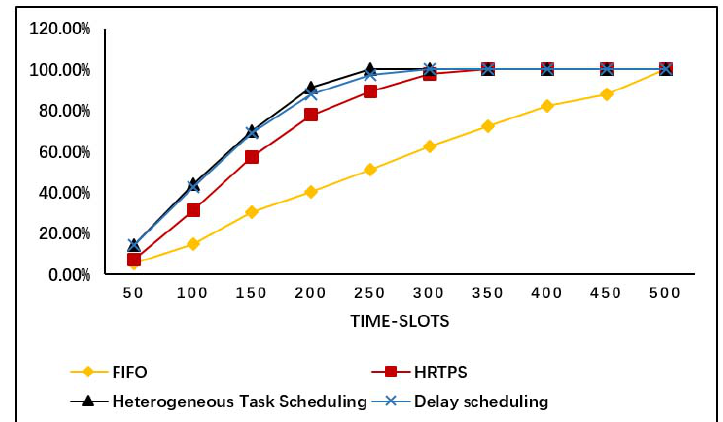
Figure 1. Experimental results of scheduling heterogeneous